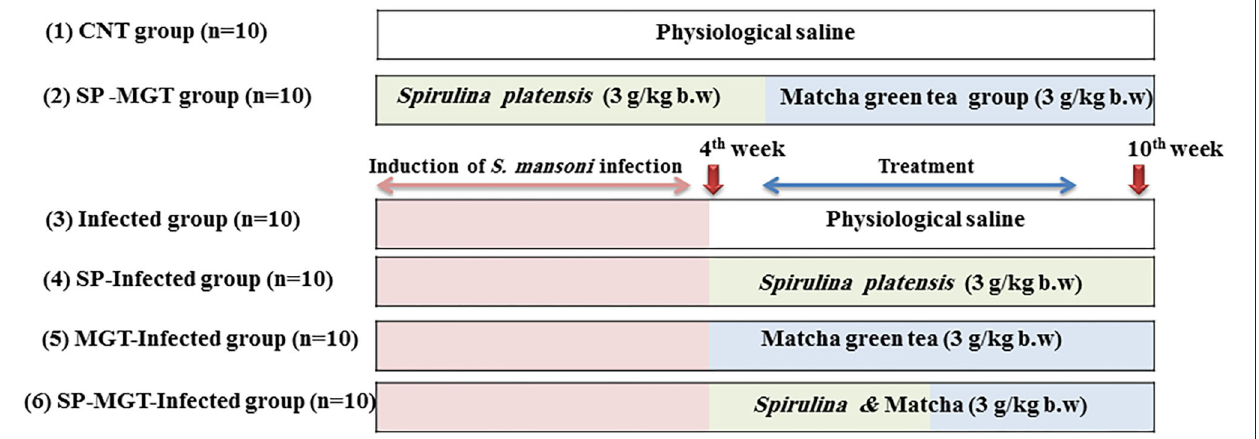
potassium (2.7%), iron (0.02%), and vitamins (C, 0.06%; A, 0.005%; and carotene,